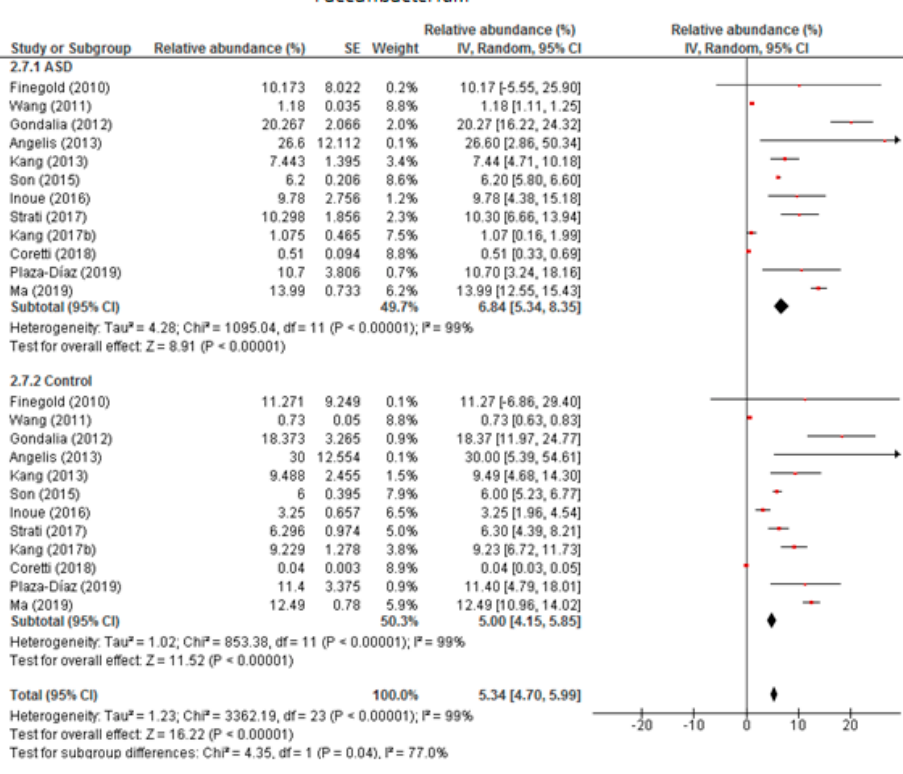
Figure 4. Forest plot of relative abundance of Faecalibacterium in children with ASD and controls. Twelve studies were included in the meta-analysis of Faecalibacterium (Figure 4). It accounted for 6.84% of the total detected microbiota in children with ASD (95% CI: 5.34, 8.35) and 5% in the control group (95% CI: 4.15, 5.85). Heterogeneity was 99% between the studies for both ASD and the control group and was also high (I 2 = 77%) between the two groups. The overall effect size was large and significant (Z = 16.22, P < 0.001). The difference in bacterial percentage between the ASD and control groups was 1.37, showing that Faecalibacterium was more abundant among the ASD children than in the controls.